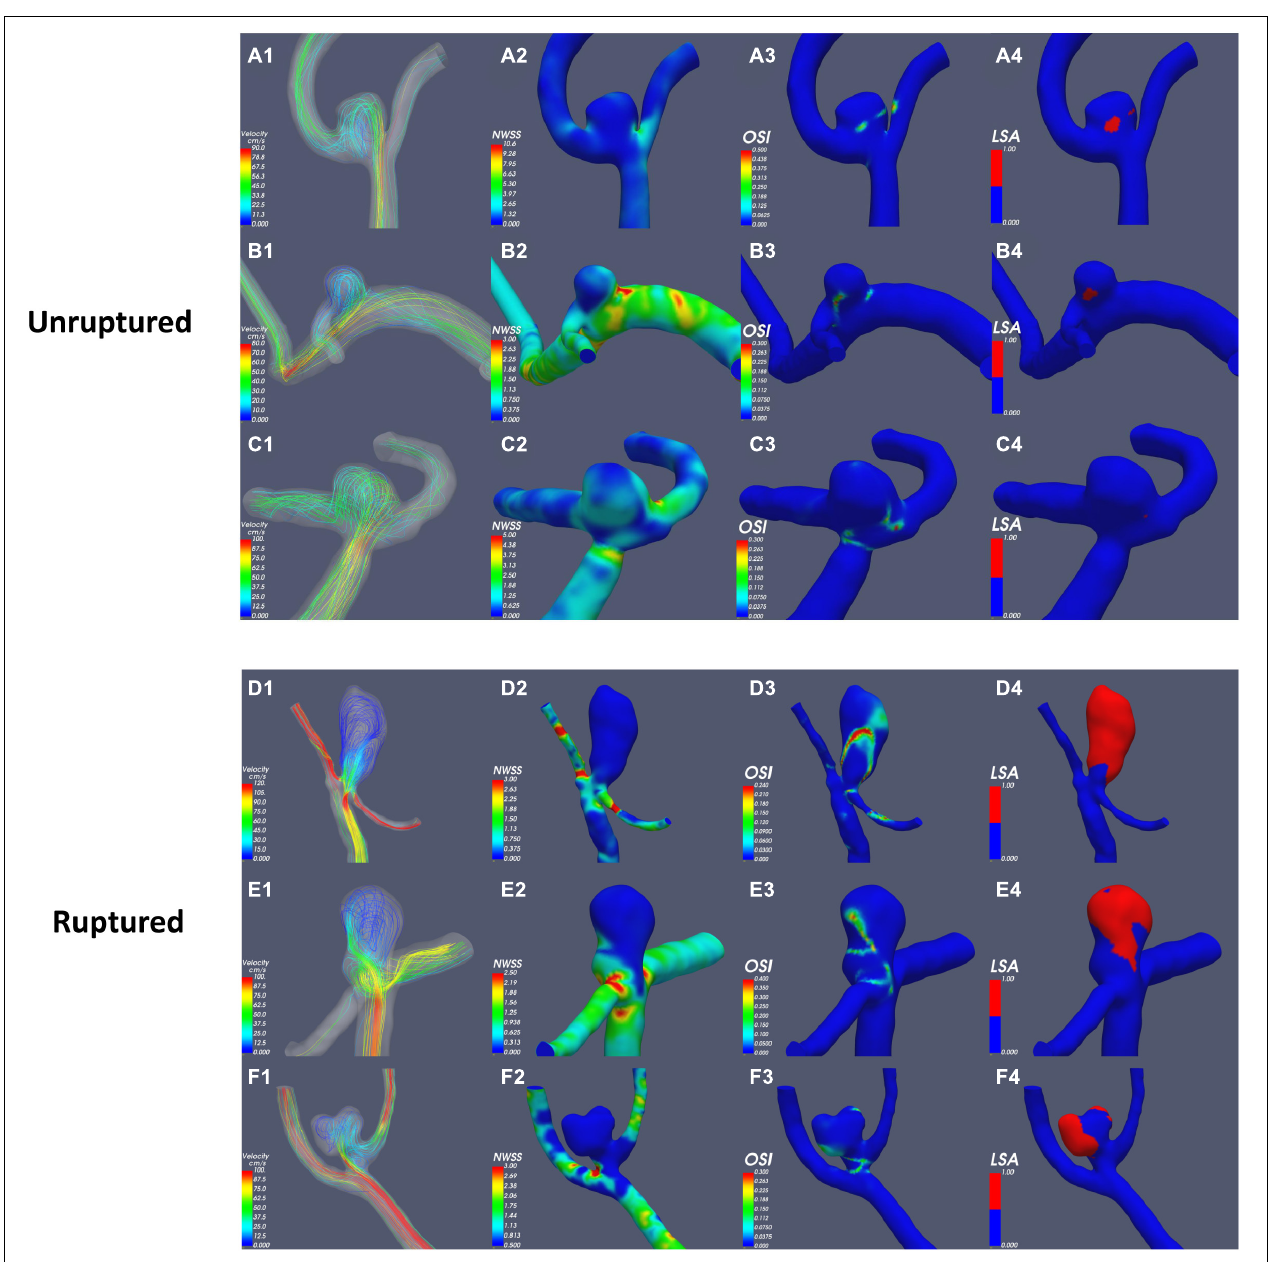
FIGURE 3 | Comparison of hemodynamic parameters between typical ruptured and unruptured PAAs. NWSS, normalized wall shear stress; OSI, oscillatory shear index; LSA, low-shear area.